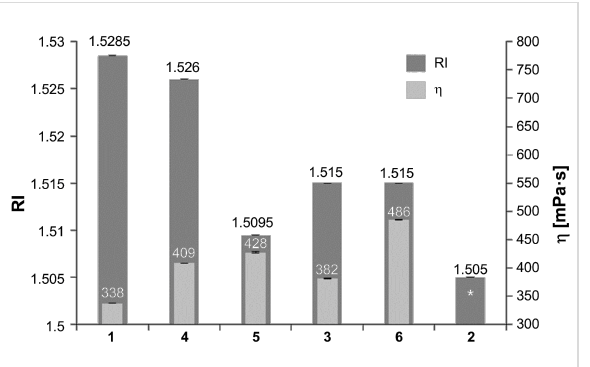
Figure 2: Exemplary photo-DSC plots for the curing of 1 and 3–6 at 37 °C.